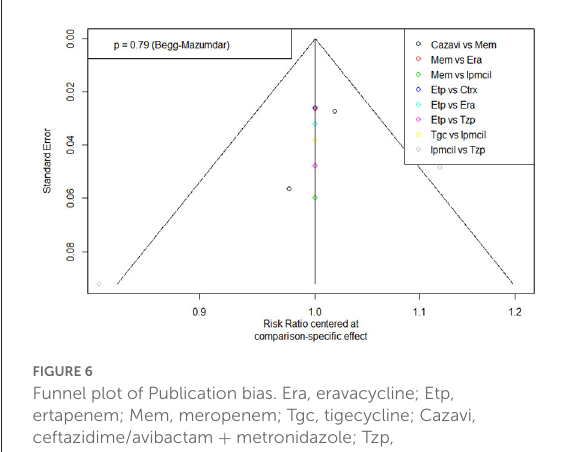
FIGURE6 Funnel plot of Publication bias. Era, eravacycline; Etp, ertapenem; Mem, meropenem; Tgc, tigecycline; Cazavi, ceftazidime/avibactam + metronidazole; Tzp, piperacillin/tazobactam; Ctrx, ceftriaxone + metronidazole; Ipmcil,